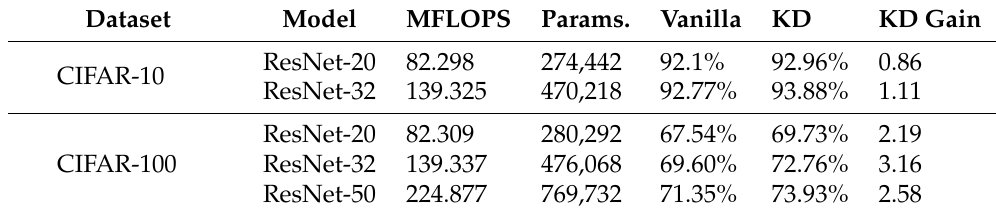
Table 2. Results on CIFAR-10 and CIFAR-100